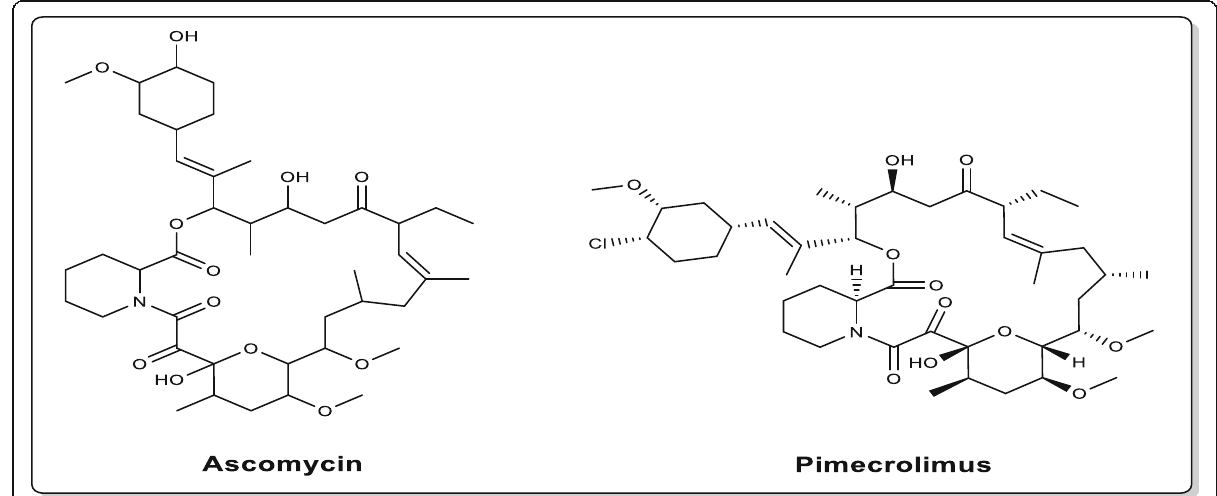
Fig. 1 Structures of ascomycin and its derivative